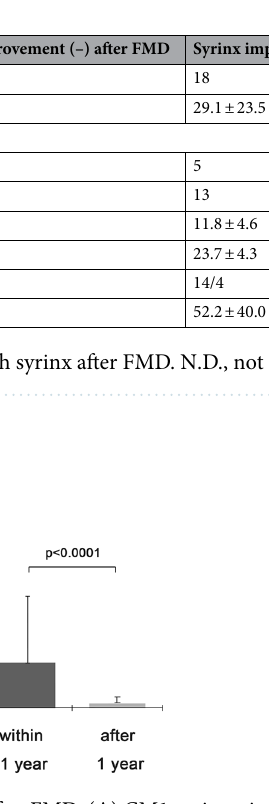
Figure 2. The rate of increase in the pSAS area after FMD. ( A ) CM1 patients in the group with syrinx improvement was significantly higher rate of increase in the pSAS areas after FMD. ( B ) the rate of increase in the pSAS areas after FMD was significantly higher in the group with syrinx improvement within 1 year compared with the group with improvement after 1 year. Imp + : syrinx improvement positive, Imp-: syrinx improvement negative.